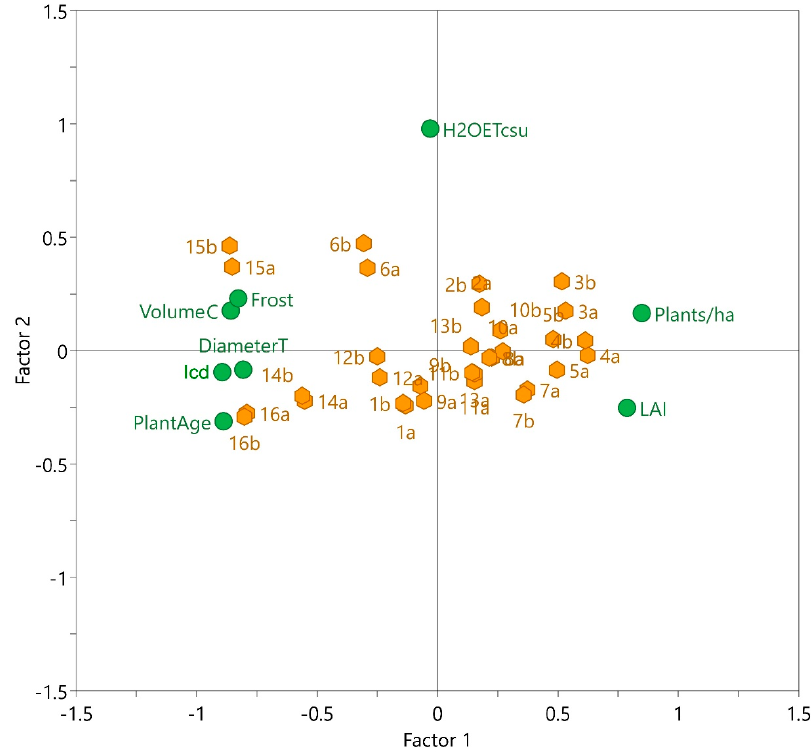
Figure 3. Biplot of the principal component analysis of predisposing factors associated with the incidence of branch canker and dieback in Chilean orchards prospected in this study in the 2014 and 2015 seasons. Scores (orange hexagons) are shown for the sixteen orchards in both growth seasons (32 observations; 2014 season (a); 2015 season (b)). Loadings are shown in green circles. R 2 X Factor 1 = 62.4%; R 2 X Factor 2 = 15.6%; R 2 Xcum = 77.9%.